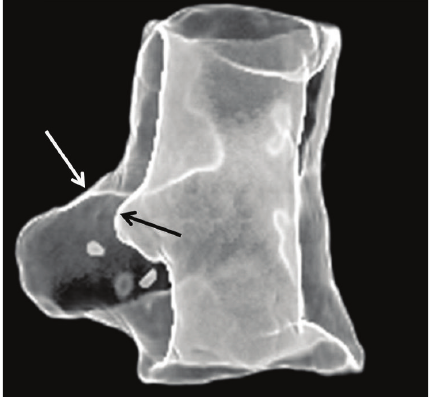
Figure 1: Computed tomography shows the internal (black arrow) and external (white arrow) surfaces of the regenerated bronchial wall, in a large animal model, of a right bronchopleural fis- tula, demonstrating abundant peribronchial tissue occluding the bronchial stump.